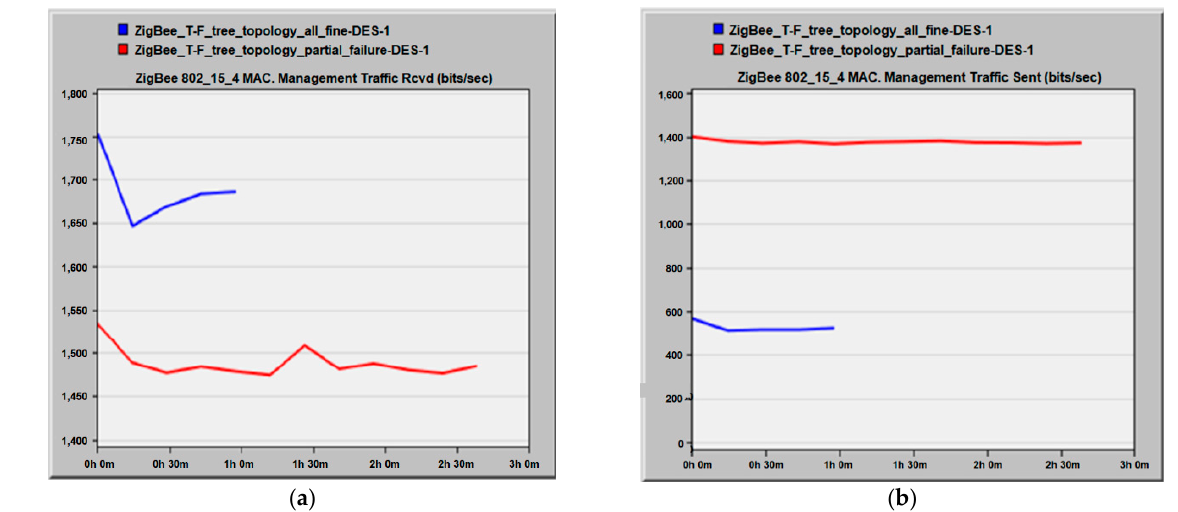
Figure 6. ( a ) Data received in bits per second; ( b ) Data sent over the network in bits per second.